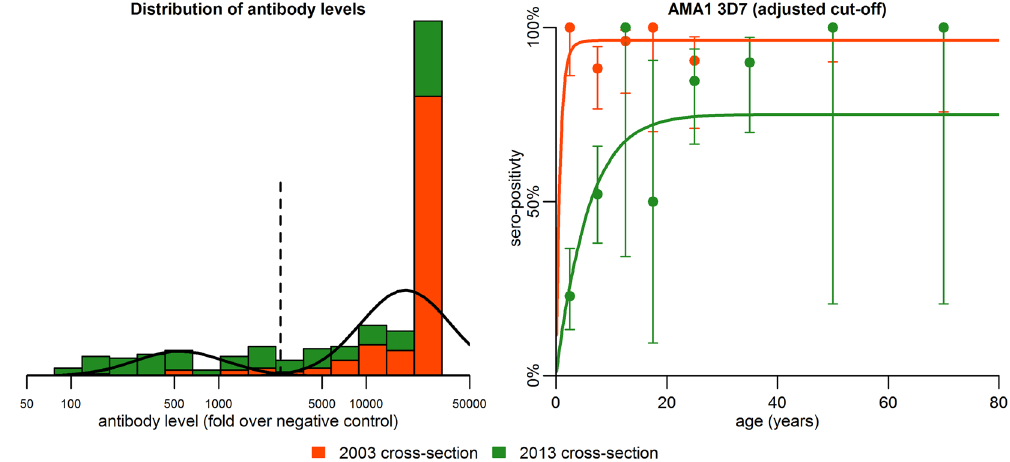
Figure 4. Seropositivity to Apical Membrane Antigen-1 3D7 allelic variant following upward adjustment of cut-off for seropositivity. The left panel shows that the cut-off for seropositivity was adjusted by fitting a mixture of two Normal distributions (solid line) to the data on antibody levels, moving from 164-fold greater than malaria naïve plasma as in Fig. 2 to 2,600-fold greater than malaria naïve plasma (indicated by the dashed vertical line). The best fit model to the revised data are shown in the right